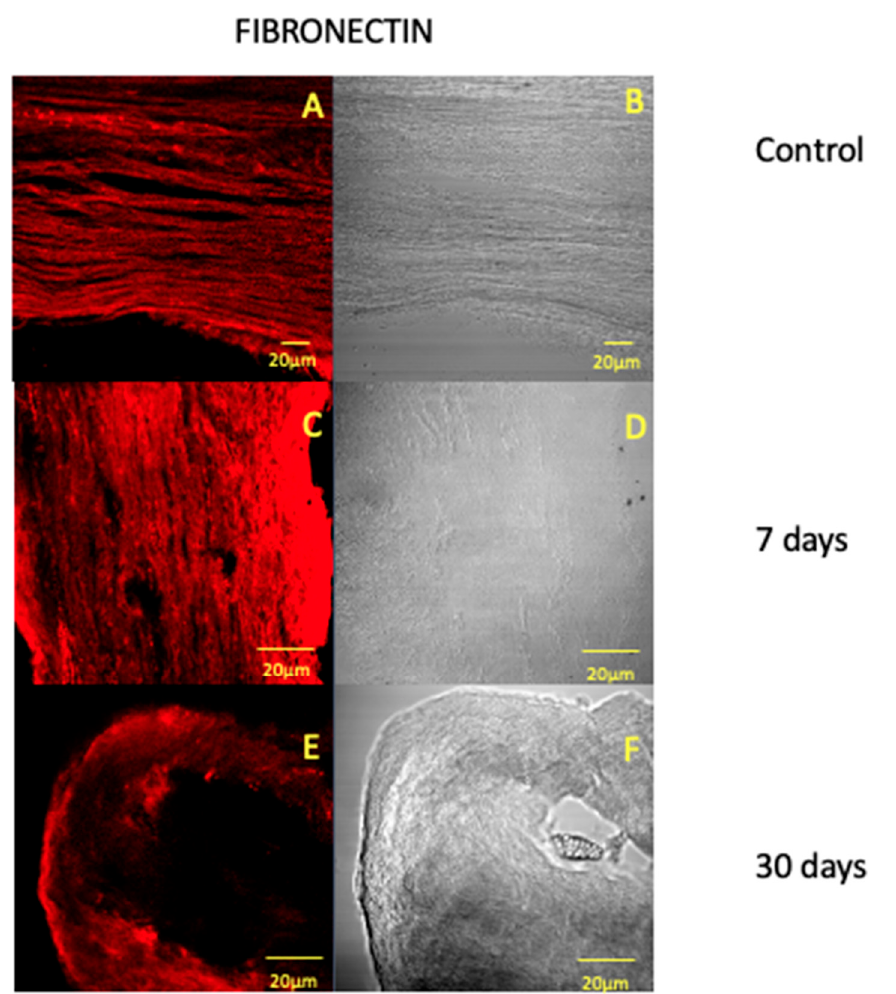
Figure 1. Compound panel of immunofluorescence reaction pictures that show fibronectin staining pattern in human dental pulp after 7 ( A ), 14 ( C ) and 30 ( E ) days after pre-calibrated force application and the corresponding transmitted light observations ( B , D , F ). The following magnifications have been used: 40× (A, B), 20× ( C , D , E , F ).